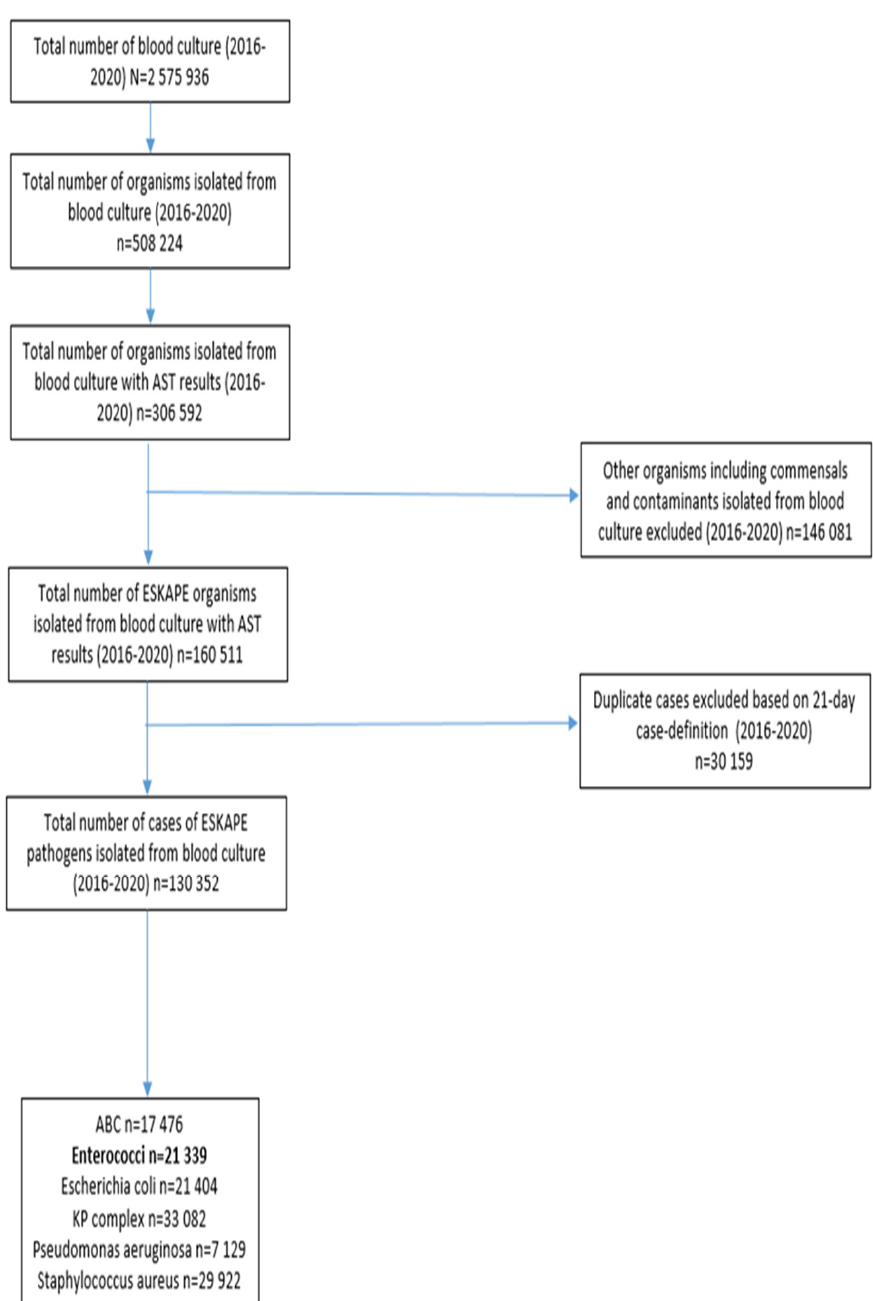
Figure 1. Breakdown of blood cultures submitted to the National Health Laboratory Service micro-